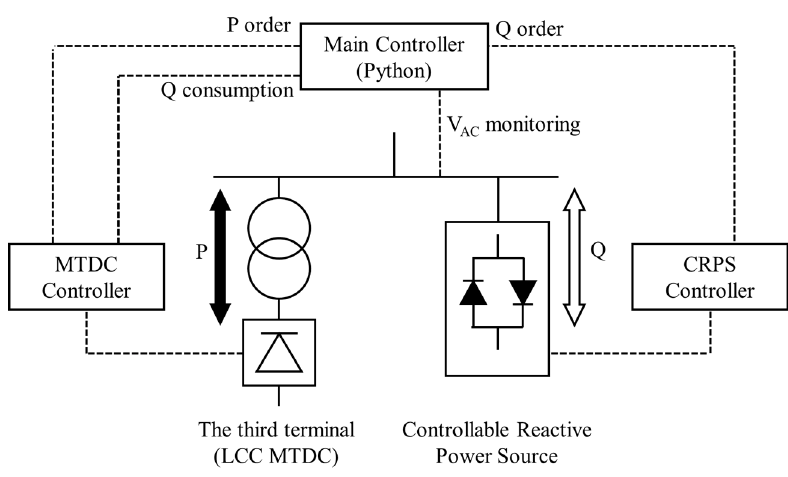
Figure 3. VSC terminal model from the use of the MTDC and the Controllable Reactive Power Source (CRPS).